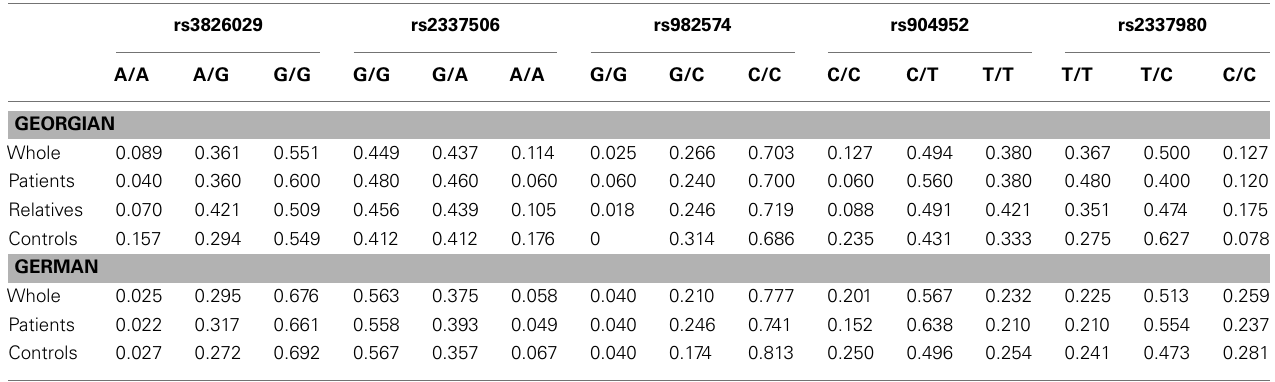
Table 5 | Genotype frequencies in German and Georgian samples.